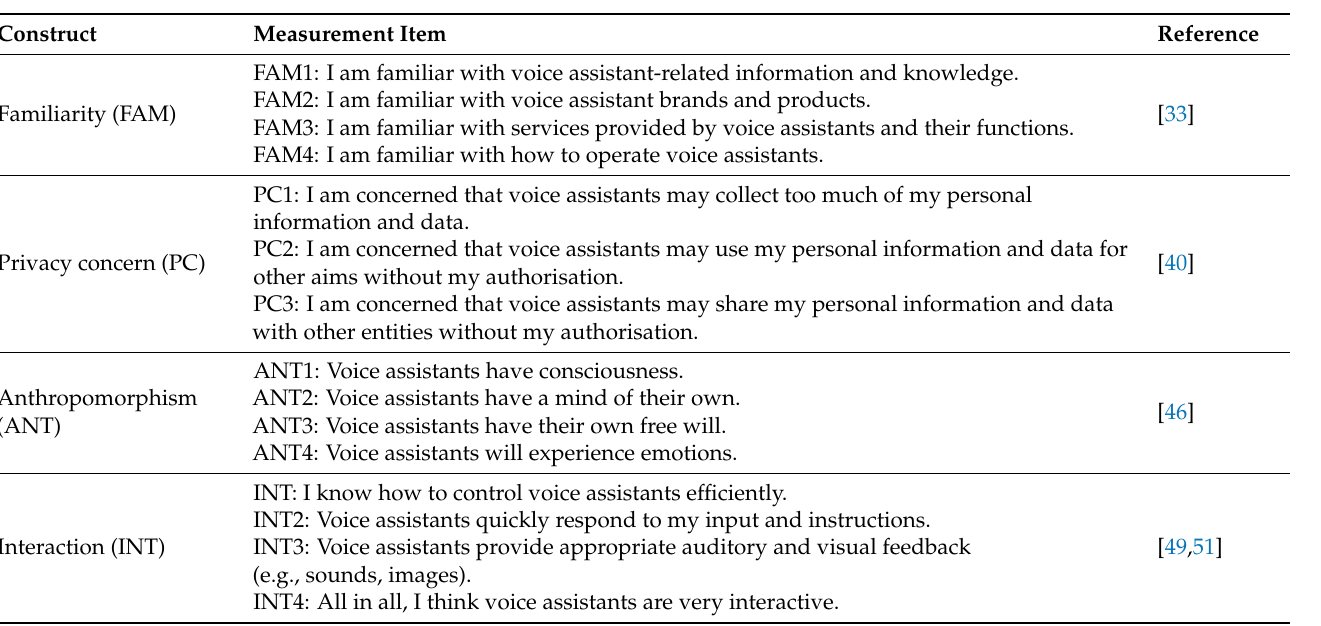
Table 1. Variables and measurement